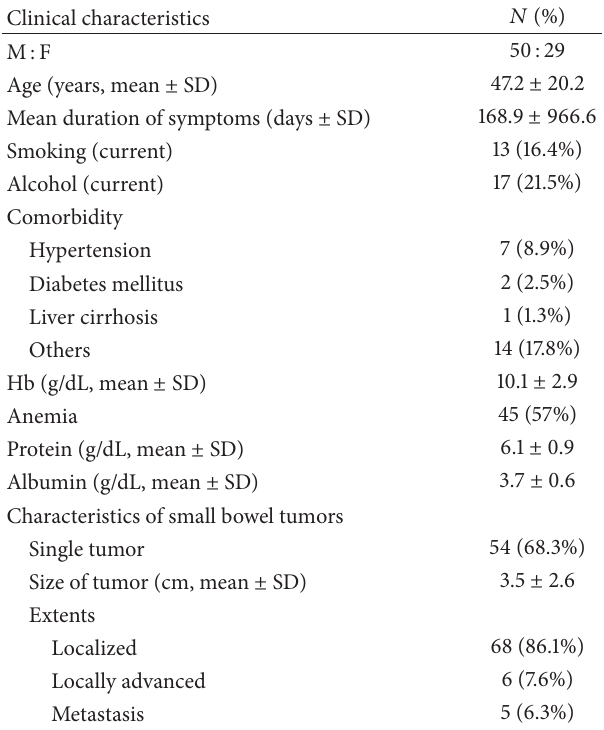
Table 1: Clinical characteristics of patients with small bowel tumors and characteristics of small bowel